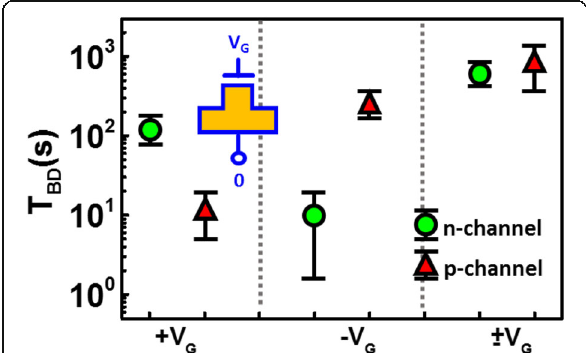
Fig. 2 Time-to-breakdown ( T BD ) of n-channel and p-channel FinFETs stressed by positive, negative, and positive + negative charging on the gate electrodes. T BD of devices under different polarity stresses suggests that the damage accumulated on the gate dielectric depends not only on the charging polarity, but also the wells under corresponding